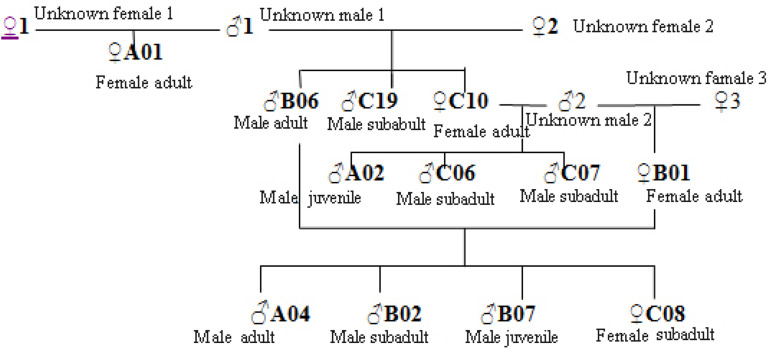
Kinship diagram of individuals in Groups A, B, and C. Based on these results, both males and females transfer between established groups, and given the existence of new groups (D and E), individuals periodically form new groups.